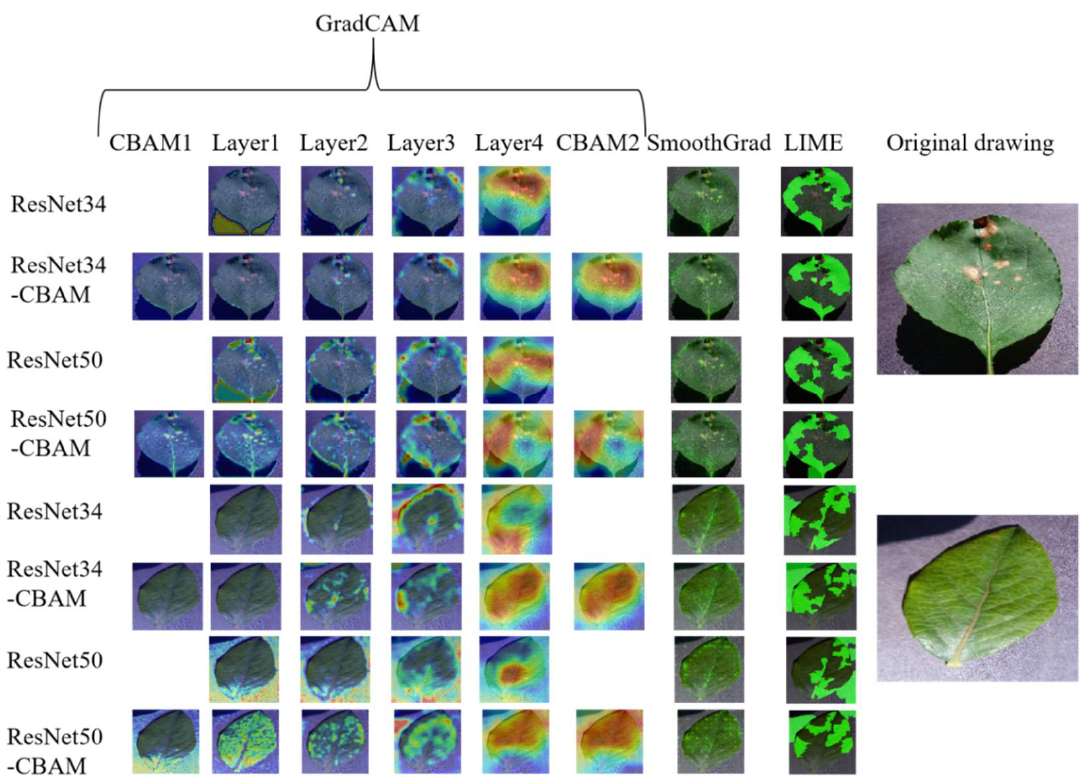
Figure 6. Visualization results of Experiment III. Each row represents the visualization result diagram of a model, and each column represents the effect diagram of GradCAM (including CBAM1, Layer1–4, and CBAM2 each layer result diagram. Layer1–4 corresponds to the four convolutional layers of random ResBlock in Figure 3), SmoothGrad, LIME, and the original image.